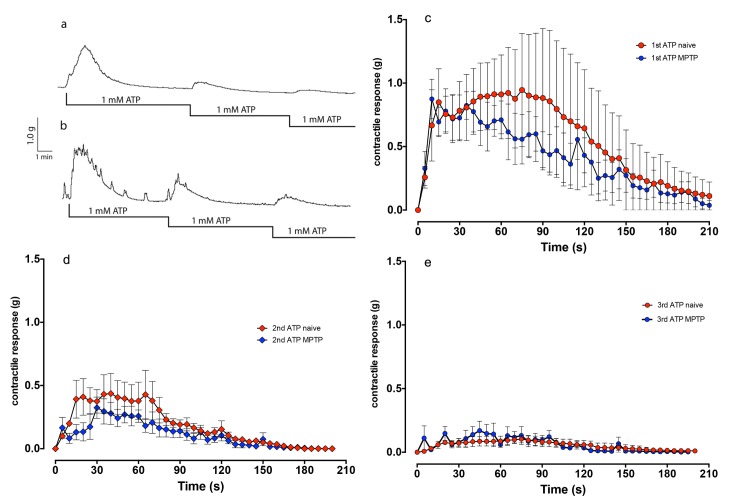
Contractile response of the isolated detrusor strips from normal (a) and MPTP-treated common marmoset (b) to ATP. Traces showing cumulative application of ATP produced similar contractile responses in both tissues, which were equally prone to desensitisation to subsequent ATP application. In panels c-e, the time course of the contractions to the first (c), second (d) and the third (e) application of ATP suggests that there were no significant differences between responses of the tissues obtained from normal (red data points) and MPTP-treated animals. Each data point represents mean ± sem (n = 4).